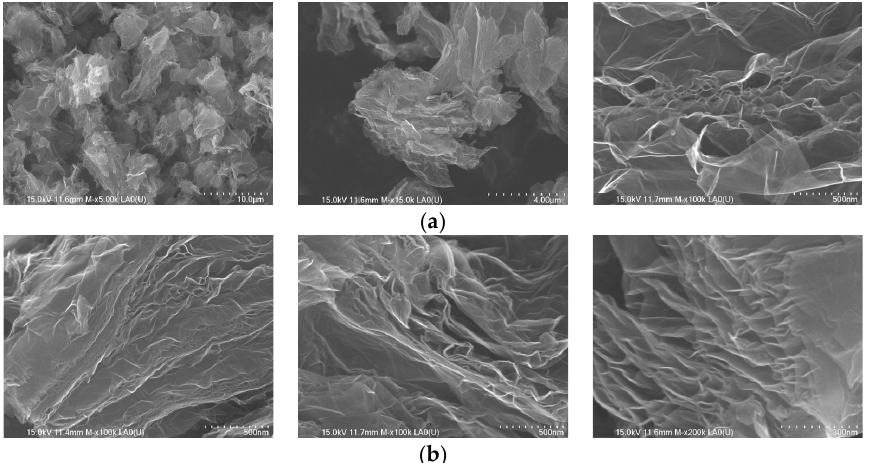
Figure 1. ( a ) SEM images of graphene oxide (GO); ( b ) SEM images of nitrogen-doped graphene oxide materials prepared by using different nitrogen precursors: N/GO_A (left)—from ammonia; N/GO_U (middle)—from urea, and N/GO_N (right)—from nitric acid.